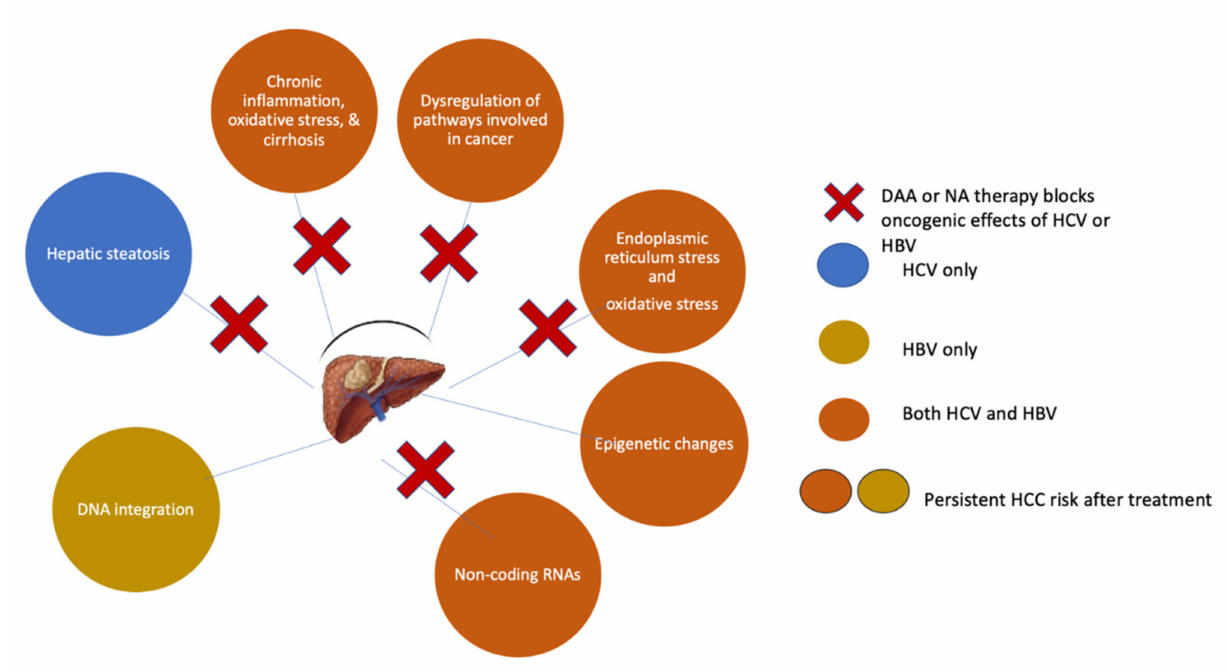
Figure 2. Mechanisms of HCC prevention and risk persistence following DAA or NA therapy. Initiating anti-viral therapy at an earlier HBV disease stage also has a mechanistic ratio- nale. Studies indicate that genomic integration of HBV DNA, which is a critical oncogenic driver of HBV-related HCC, is frequently detected in young patients with immune-tolerant disease [90]. Additionally, other pro-oncogenic features of HBV, including HBV-specific T cell responses and hepatic necroinflammatory activity, are often detectable in young immune-tolerant patients [91]. Based on these findings, it is tempting to assume that